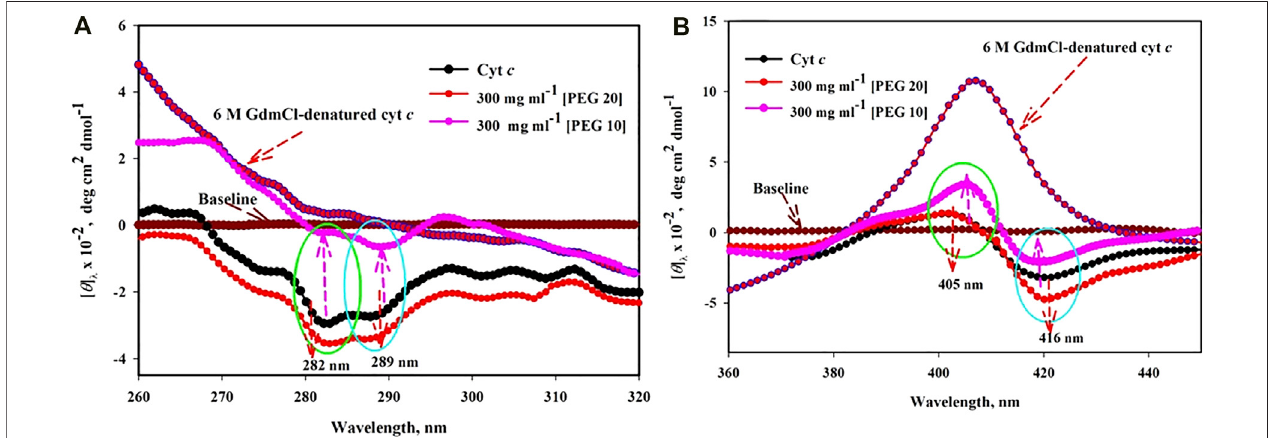
FIGURE 3 | Near-UV CD (A) and Soret CD (B) spectra of cyt c in the presence of highest concentration (300 mg ml − 1 ) of PEG 10 and PEG 20.